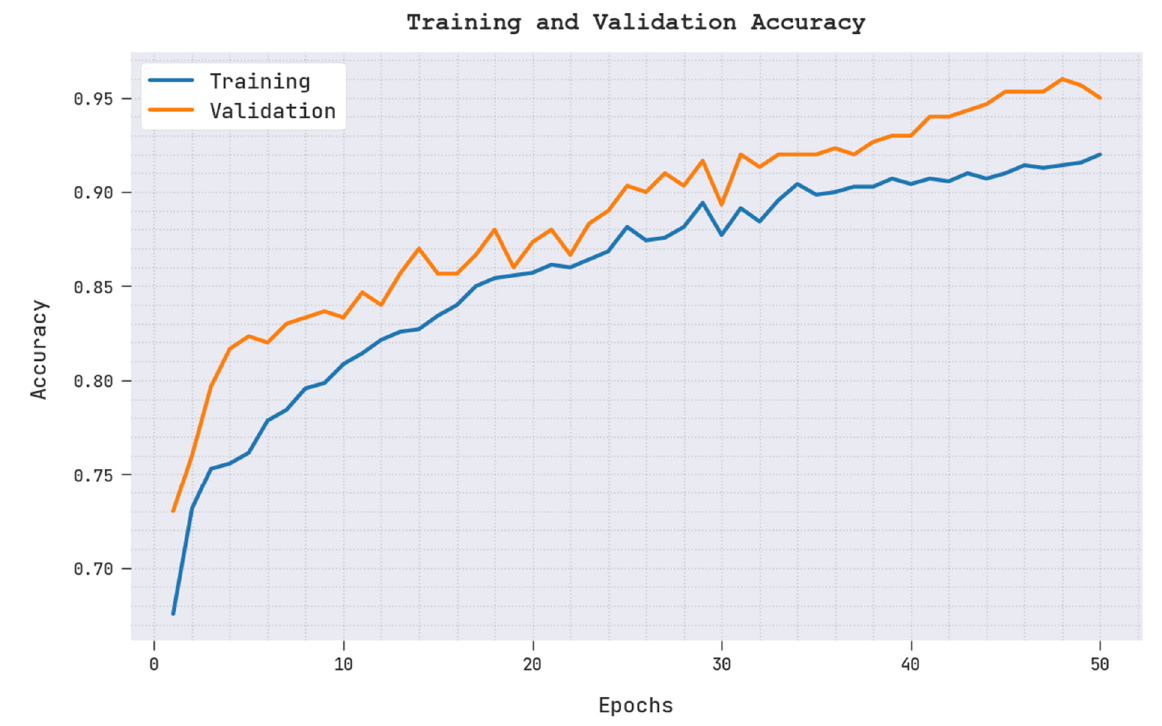
Figure 7. TR acc and VL acc analysis of the AOTL-CDA3S system.